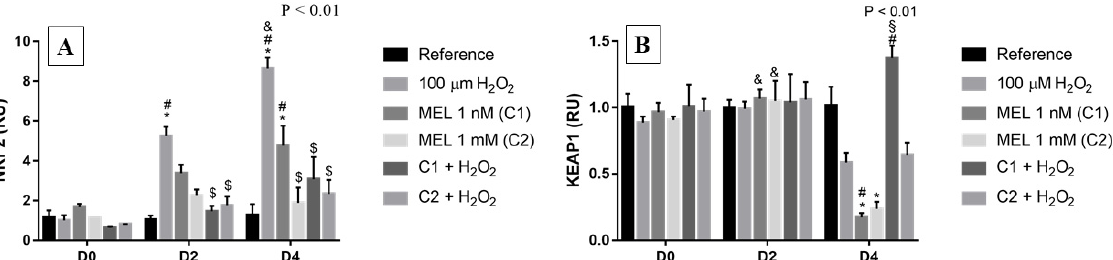
Figure 3. Relative expression of NRF2 and of its regulator KEAP1 in K562 erythroid cells: ( A ) NRF2 gene expression and ( B ) KEAP1 gene expression. Reference: K562 cells without induction of oxidative stress and not treated with melatonin; 100 µM H 2 O 2 : Cells under stress induction with hydrogen peroxide; C1: cells treated with 1 nM melatonin; C2: cells treated with 1 mM melatonin; C1 + 100 µM H 2 O 2 and C2 + 100 µM H 2 O 2 : sets of cells treated with the same melatonin concentrations associated with stress induction; D0: before the differentiation, D2: beginning of cell differentiation; D4: maximum of the differentiation process. * Effects of treatments within each period compared to the respective reference groups; # Effect of the incubation period within each treatment compared to their counterparts in D0; & Effect of the incubation period between D2 and D4 within the same treatment; § Effect of C1 compared to other treatments within the same period; $ Protective effect of melatonin. Test performed: GLM with 2-way ANOVA design, complemented by Bonferroni test.